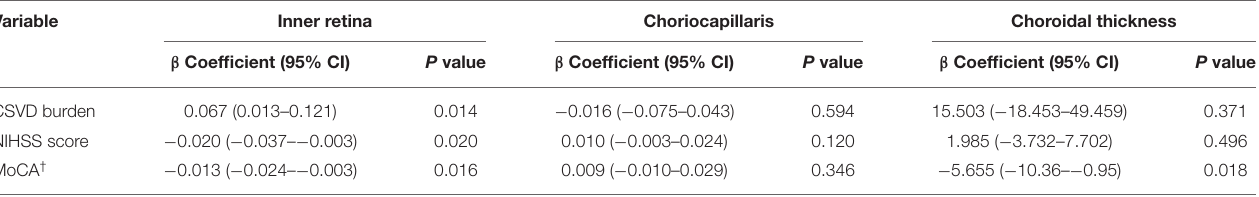
TABLE 3 | Multivariate Regression Analysis between SS-OCTA parameters and clinical and radiological indicators of SSI.